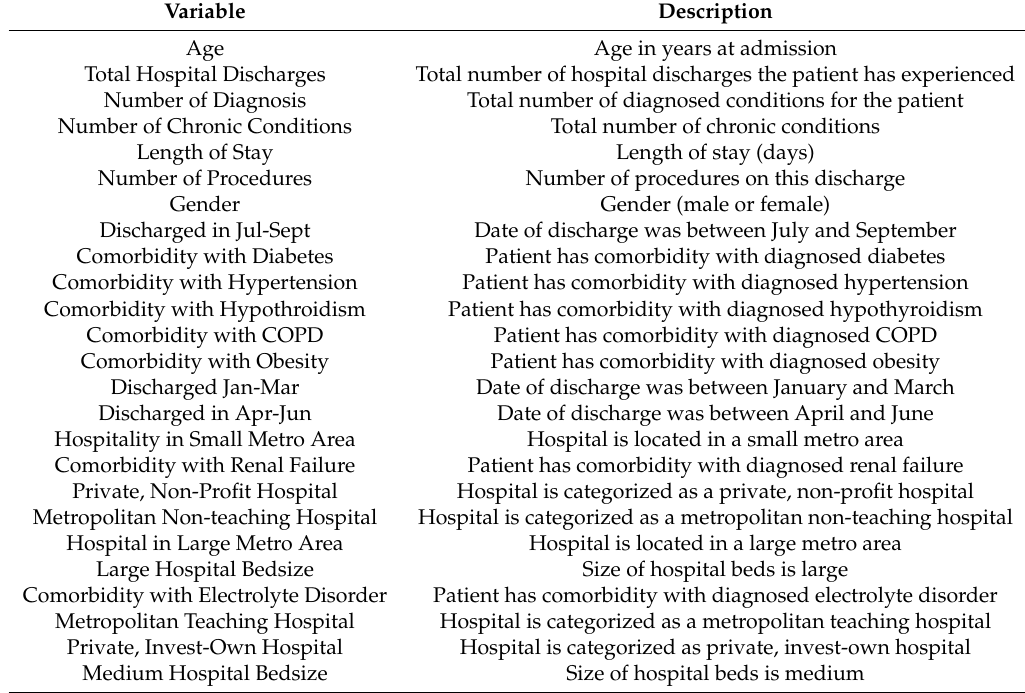
Table 1. Description of the top 30